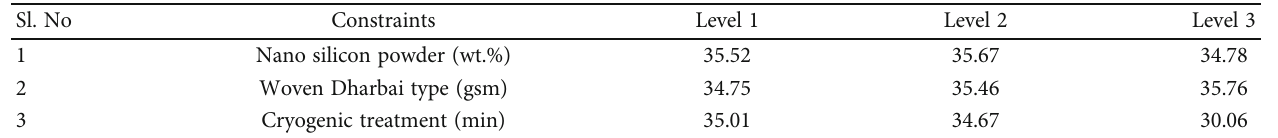
Table 3: Average values of S/N ratio of nanocomposites.